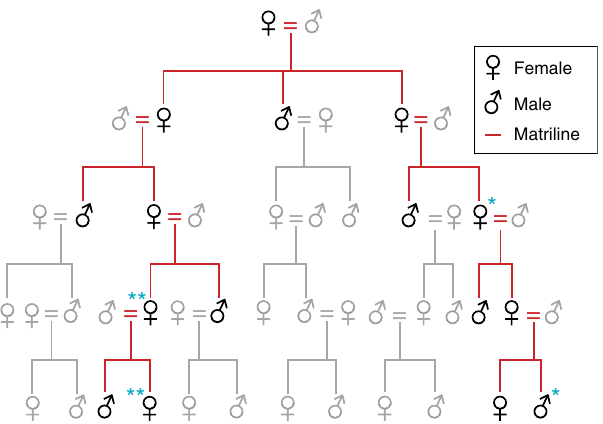
Figure 4 | Diagram of a hypothetical Chacoan matriline. The diagram illustrates the inferred relationships for at least two pairs of individuals interred in room 33. Matriline members and descent are highlighted in red. Lineal relationships (mother–daughter and mother–son) and sibling relationships are first degree. The blue * shows the grandmother–grandson relationship suggested for crania 8 and 10 and the blue ** indicates the mother–daughter relationship suggested between crania 1 and 7. Ethnographically, matrilineal systems are present in all the Western Pueblos (Hopi, Zuni, Acoma, Laguna), and also among Rio Grande Keresans (see Supplementary Fig. 7). Graphical layout: T.